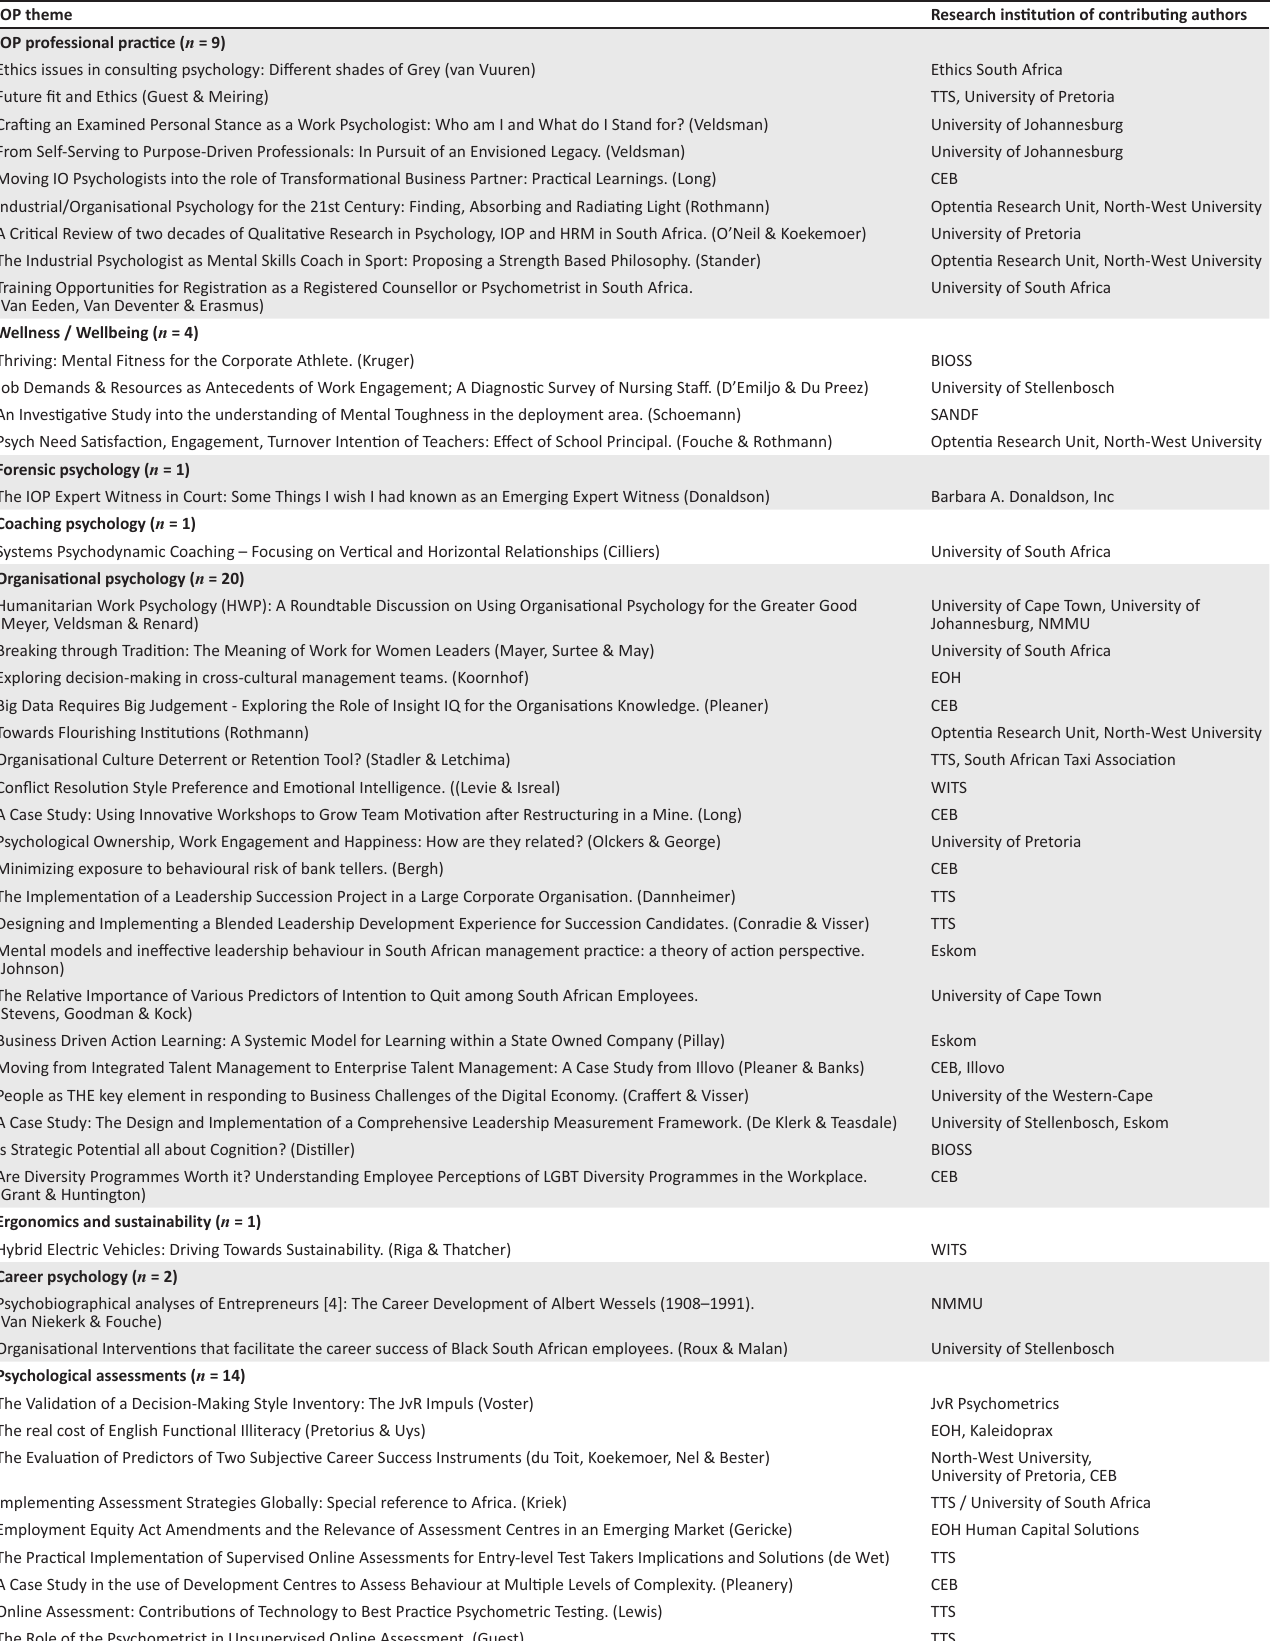
TABLE 2: Overview of SIOPSA’s 17th Annual Conference IOP paper presentation